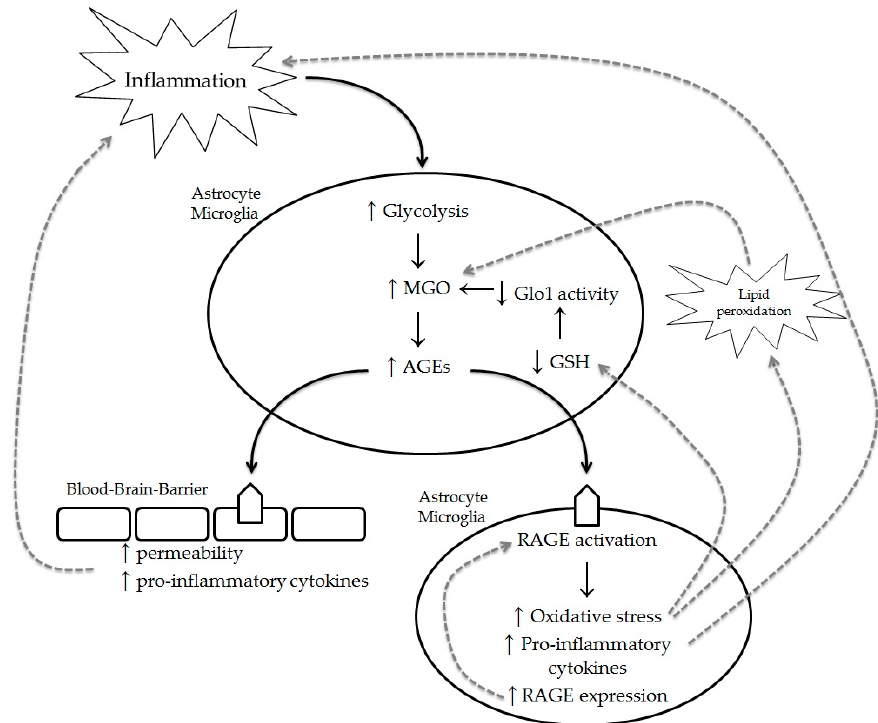
Figure 2. Schematic overview of the effects of methylglyoxal (MGO) on key cells in MS development. The inflammatory environment in the central nervous system (CNS) during MS leads to an increase ( ↑ ) in glycolysis in astrocytes and microglia. This induces ( ↑ ) the production of MGO and subsequently, AGEs. AGEs activate RAGE, which is present on astrocytes, microglia, and endothelial cells, leading to increased oxidative stress, the production of pro-inflammatory cytokines, and increased RAGE expression. Moreover, the BBB is affected by AGEs, leading to a loss of tight-junction proteins and thereby increasing permeability. Several positive feedback loops (dashed lines) are possible to further stimulate the inflammatory environment and moreover, increase the AGE levels in the CNS. The upregulation of RAGE upon its activation leads to an increased pathway activation and thus, oxidative stress and pro-inflammatory cytokines. Moreover, the production of pro-inflammatory cytokines contributes to the inflammatory status of the CNS. In addition, oxidative stress depletes ( ↓ ) glutathione (GSH), leading to decreased ( ↓ ) Glo1 activity, and stimulates lipid peroxidation, all of which contribute to the production of MGO, among others. ↑ upward arrow indicates increased production, ↓ downwards arrow indicates decreased production and/or